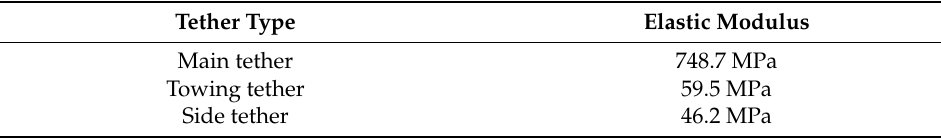
Figure 9. Tether segment tension during deployment. Table 2. Summary of elastic moduli of net